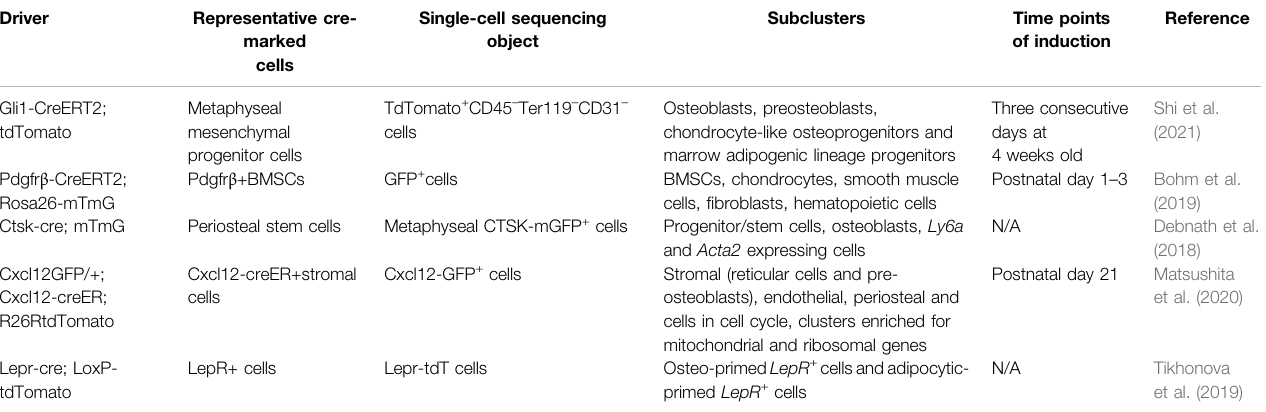
TABLE 2 | Lineage-tracing mouse transgenic lines with stem/progenitor markers for scRNA-seq.